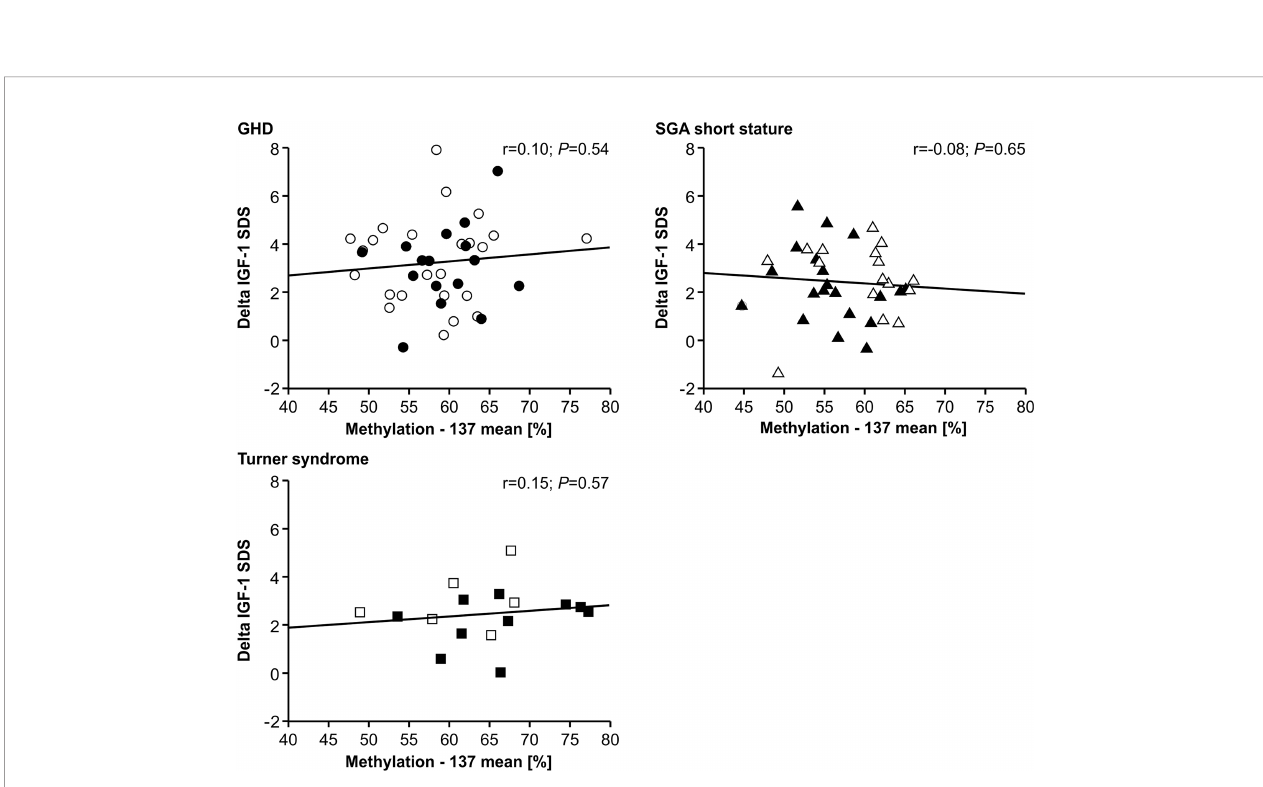
FIGURE 4 | Baseline IGF-1 SDS and IGF1 P2 methylation at position -137. Filled symbols indicate patients with exon3-deleted GHR allele.